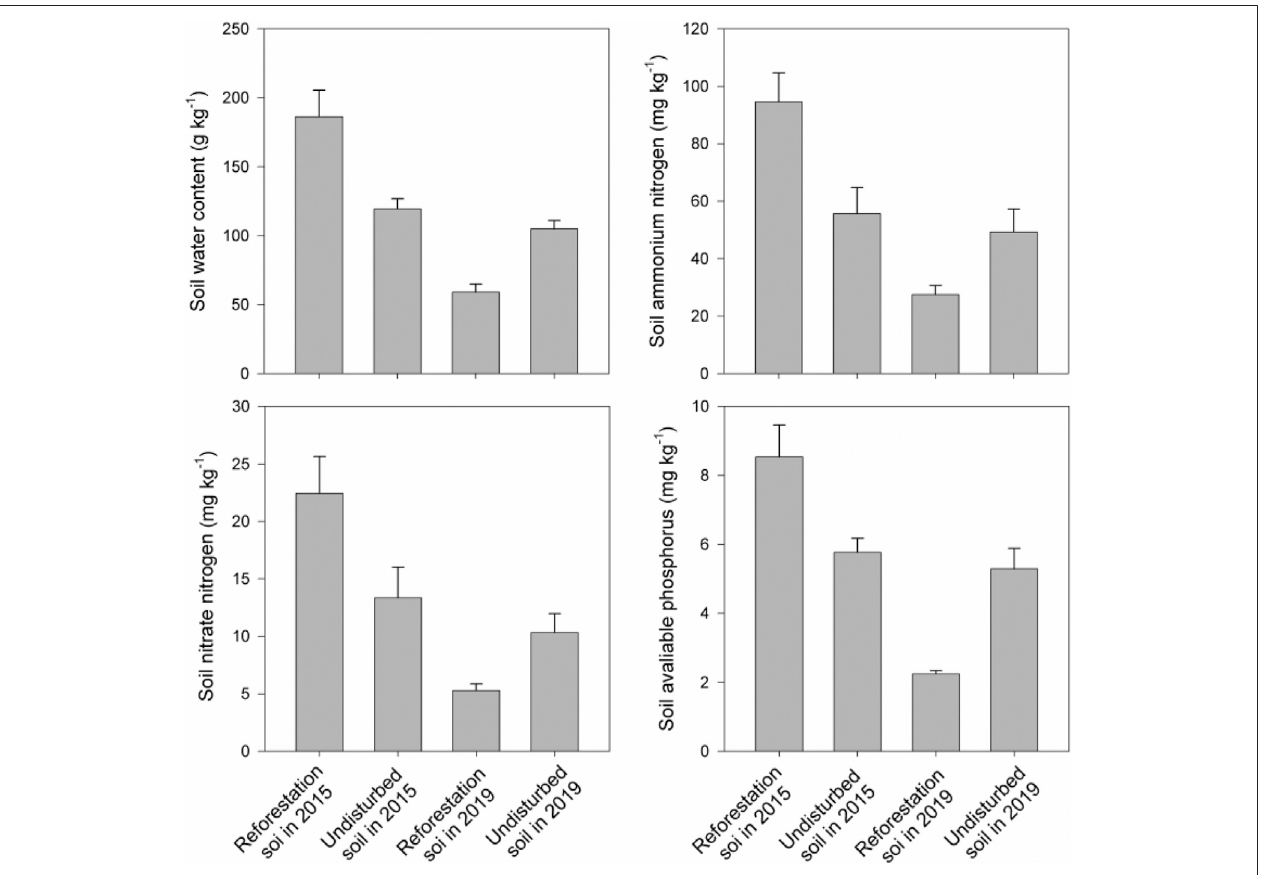
FIGURE 5 | Variation in soil water content, soil available nitrogen (ammonium and nitrate N), and soil available phosphorus among the initial local high nutrient soil before reforestation sampled in 2015 (reforestation soil in 2015), soils in undisturbed old-growth tropical rainforest sampled in 2015 (undisturbed soil in 2015), soils in reforestation area sampled in 2019 (reforestation soil in 2019) and soils in undisturbed old-growth tropical rainforest sampled in 2019 (undisturbed soil in 2019).